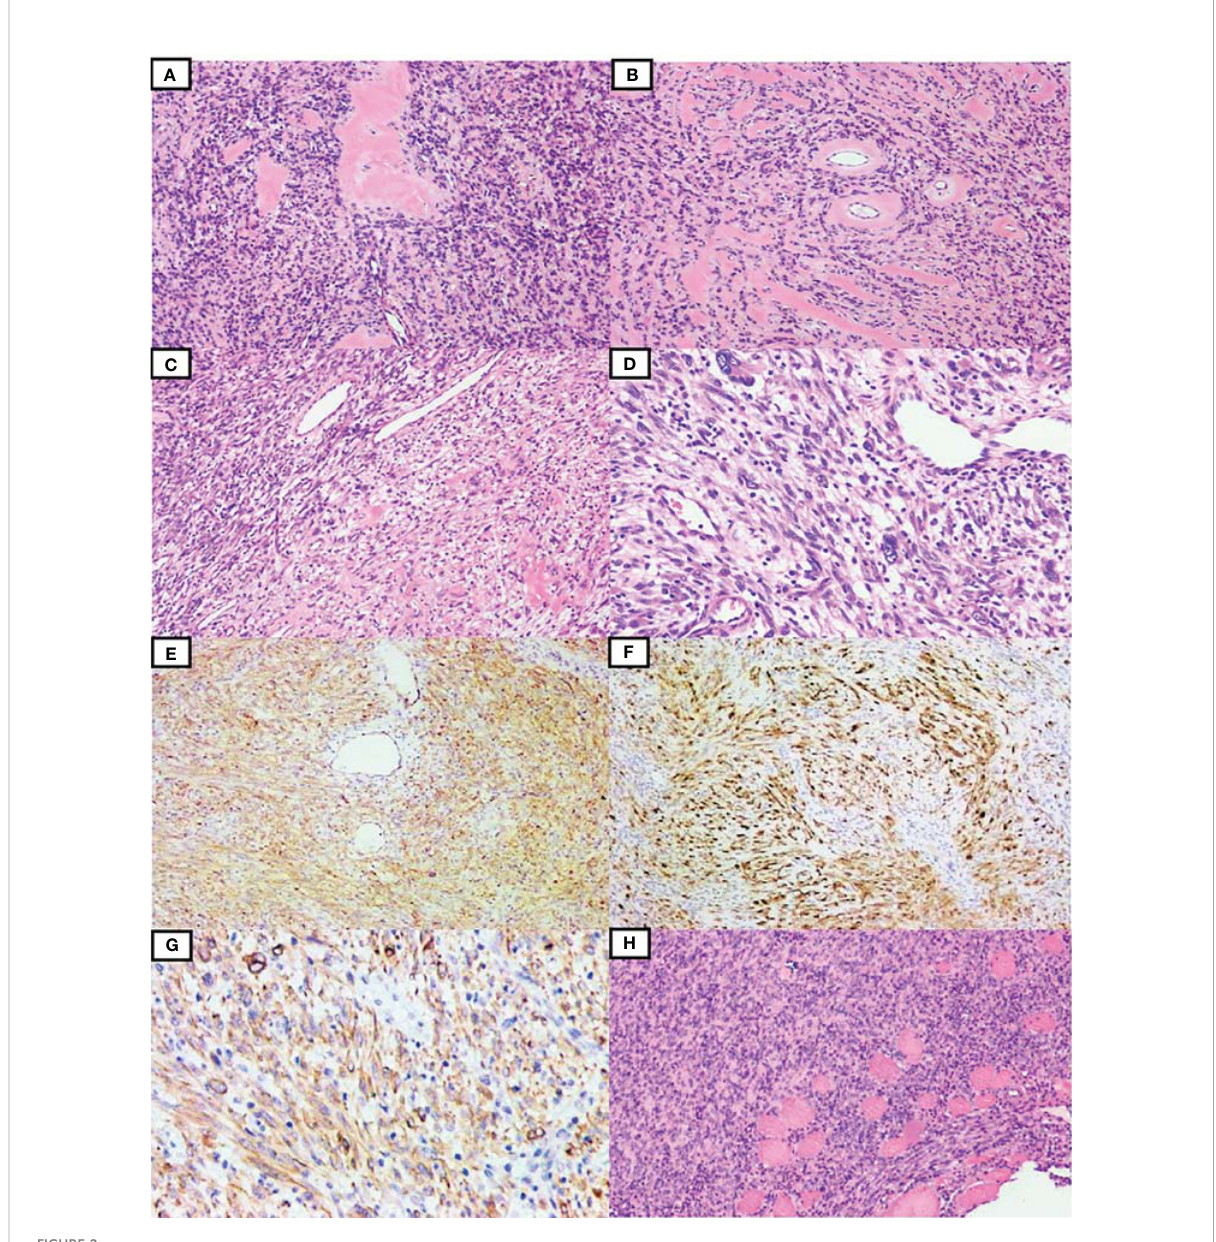
FIGURE 2 Clinicopathological fi ndings of the tumor in case 2. The tumor consisted of spindle-shaped mesenchymal cells with stromal and perivascular hyalinization (A, B) . Focal staghorn vessels and clusters of clear cytoplasmic cells were observed (C) . Giant multinucleated tumor cells and in fl ammatory in fi ltration were also seen (D) . The tumor cells were diffusely positive for CD34 (E) , S100 (F) , and ALK-D5F3 (G) . The relapsed tumor showed diffuse proliferation of compact spindle cells, also in fi ltrating striated muscles (H)